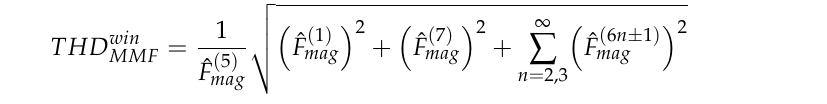
Figure 14. For 12-slot/10-pole DTP-FL winding, resultant winding MMF changes with time and space.